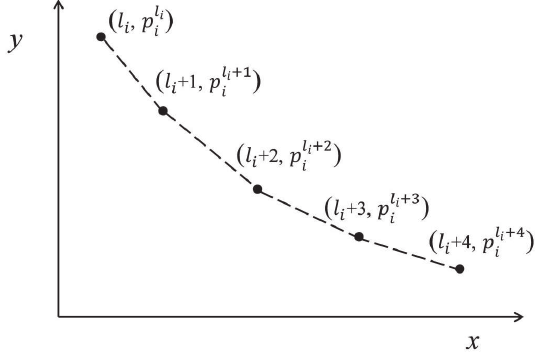
Figure 2. Example of a piecewise linear